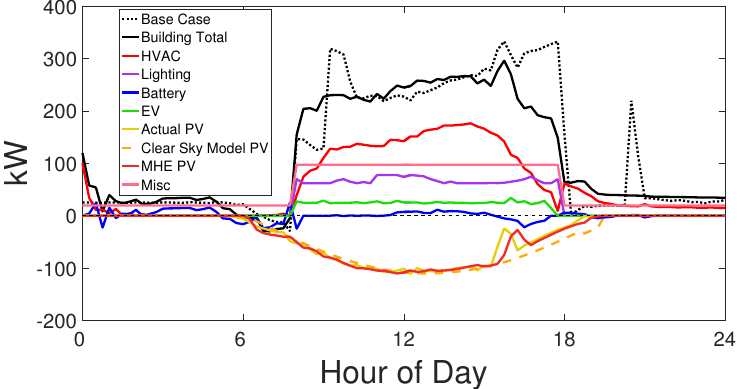
Figure 13. Power usage profiles for the entire building and the individual subsystem under the Peak Demand MPC with a fifteen-minute moving horizon solar forecast and a five-hour MPC horizon, referenced with the total building load under the rules-based control